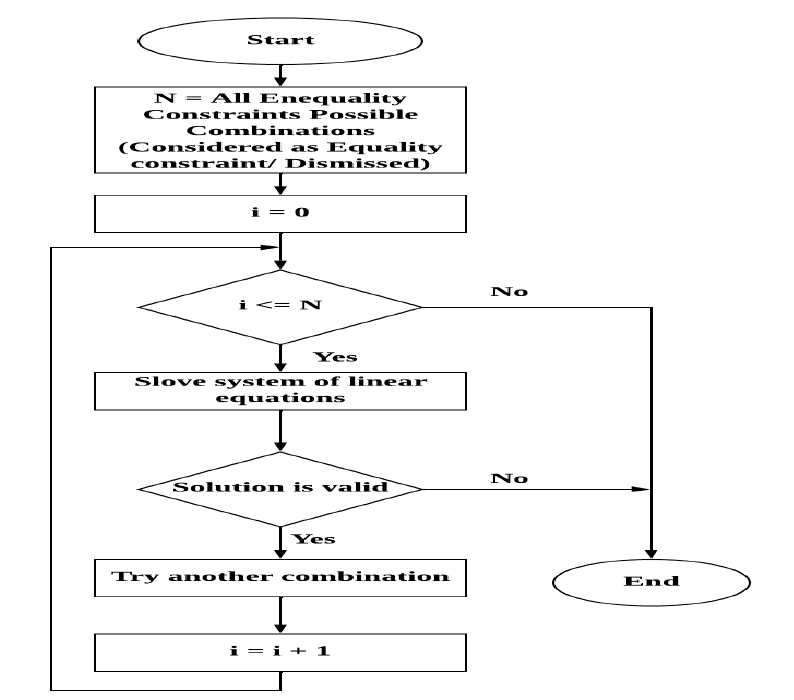
Figure 3. Solving the DC-OPF